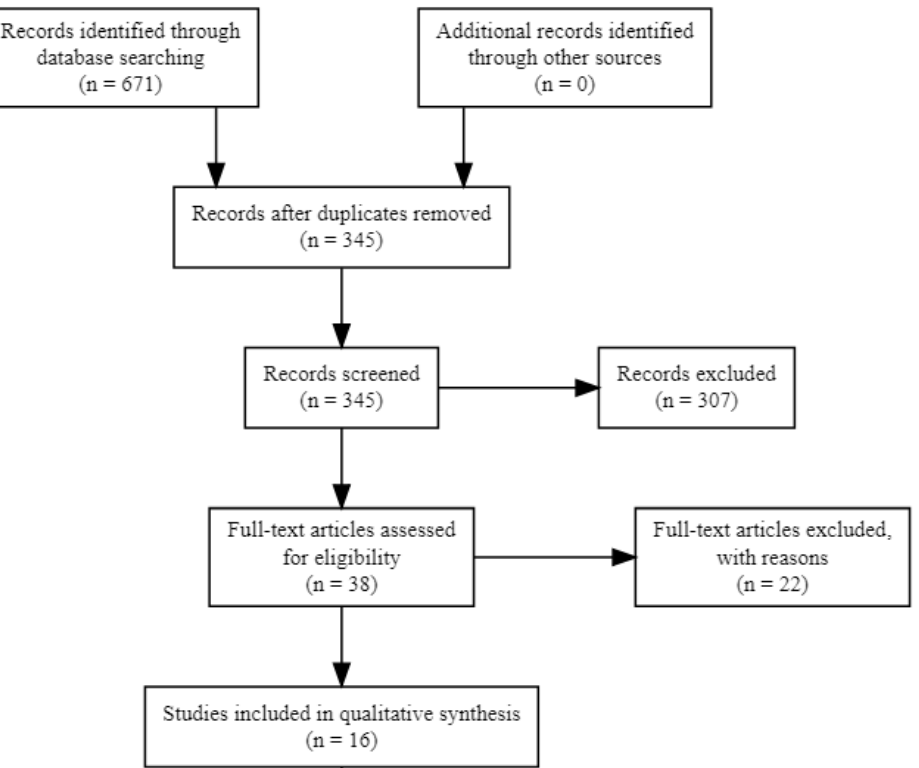
Figure 1. Results of search process: PRISMA flow